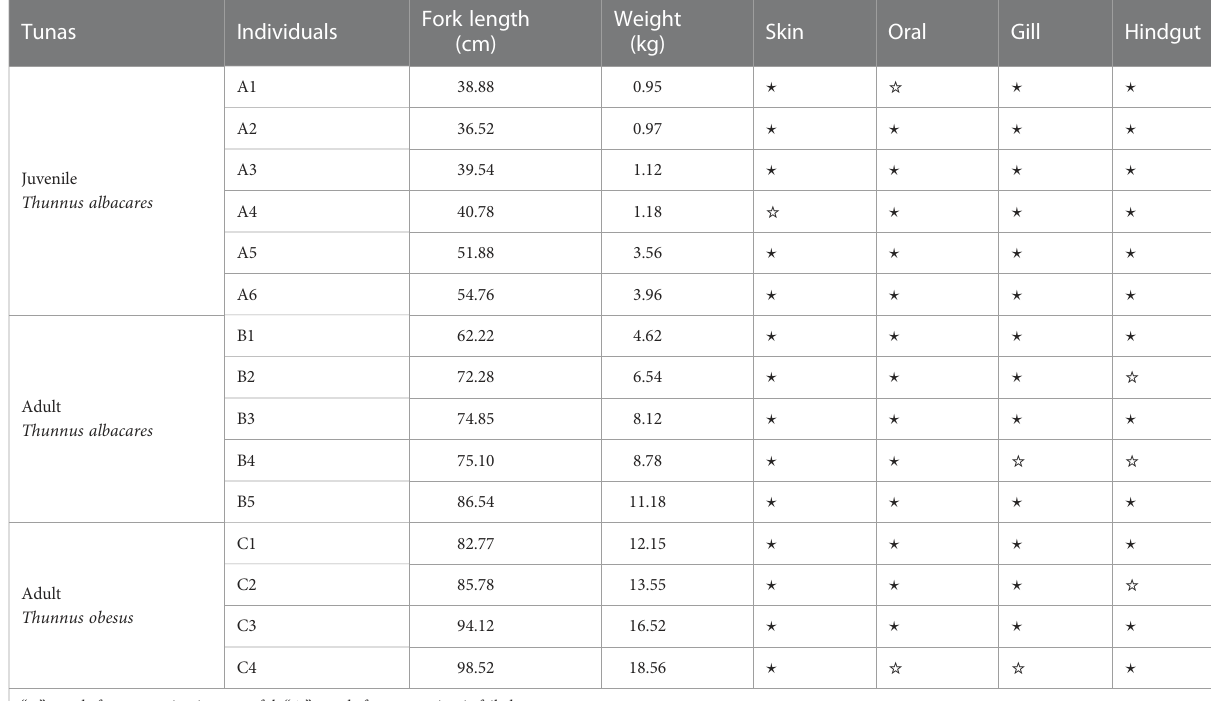
TABLE 1 Samples information collected from tunas.